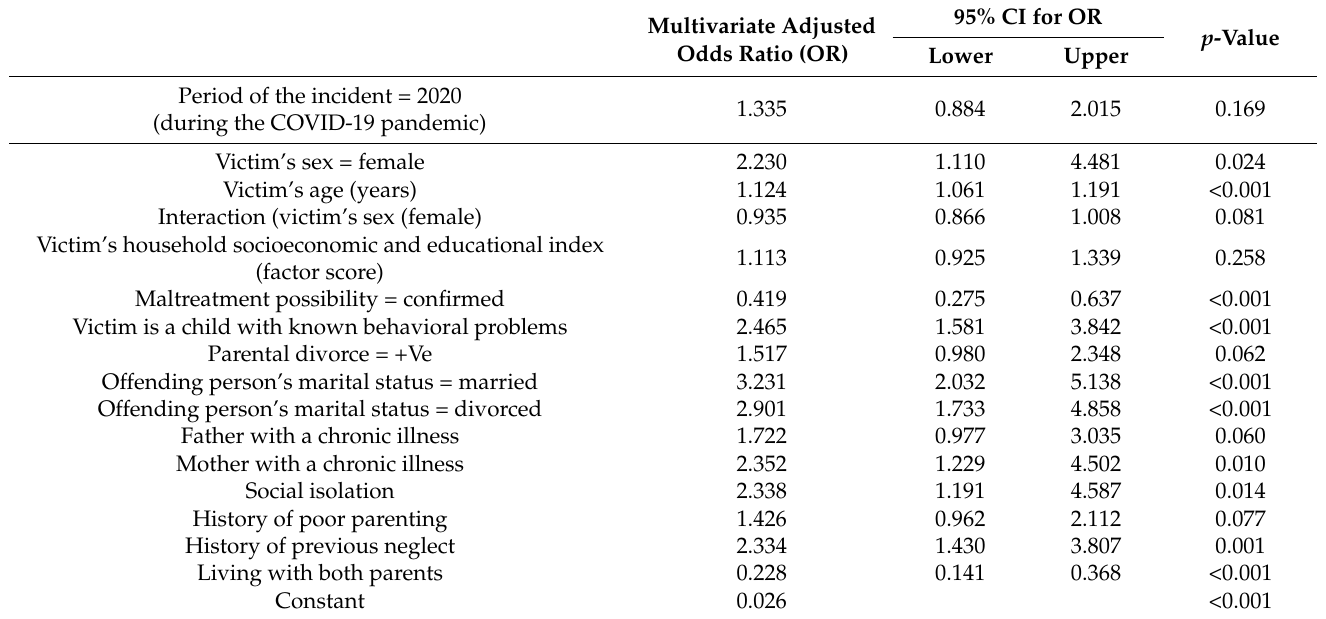
Table 6. Multivariate logistic binary regression analysis of children’s odds of emotional maltreatment ( n =